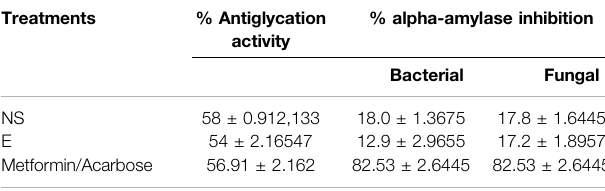
TABLE 2 | Antidiabetic potential of extract and nanosuspension of N. sativa